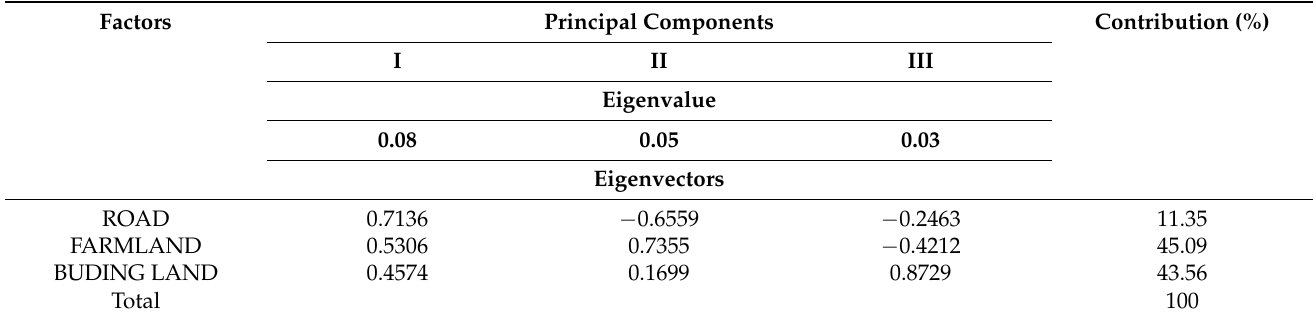
Figure 6. VSI spatial distribution ( left ) and area statistics of the five vulnerability levels ( right ) from 2000 to 2015. The his- togram represents the area of each level, and the line chart represents the percentage area of each level. Table 4. The different index contributions of